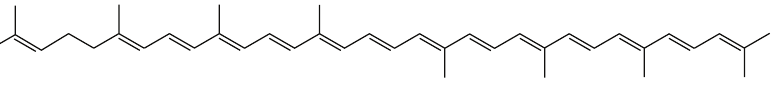
Figure 6: Molecular structure of lycopene (adapted from [169]).